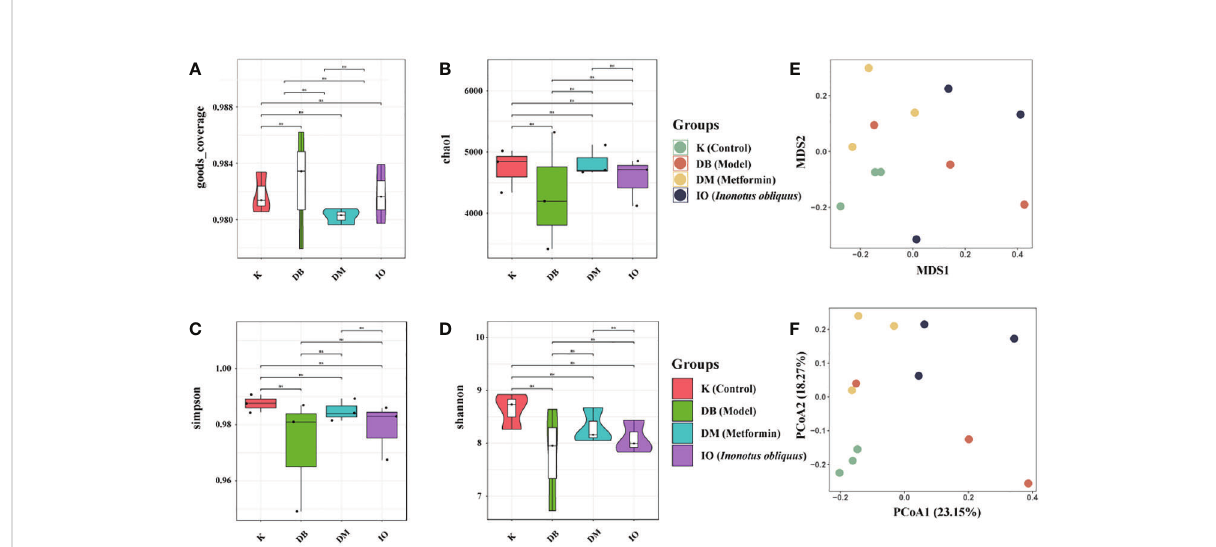
FIGURE 4 Alpha and Beta diversity analysis. Alpha diversity analysis indicates the degree of species diversity within a single biological environment. Beta diversity analysis clearly shows a clear separation between DB groups and IO groups. (A) Goods coverage; (B) Chao1; (C) Simpson; (D) Shannon. (E) NMDS1 and NMDS2 are two sorting axes, each point in the fi gure represents a sample, the same color is the same group, the IO group is separated from the module DB group; (F) Weighted UniFrac PCoA map based on OTU abundance. NS, non-signi fi cant, p>0.05. The fi rst two principal coordinates (PC1 and PC2) of PCoA from weighted UniFrac were plotted for each sample to assess similarity between samples and